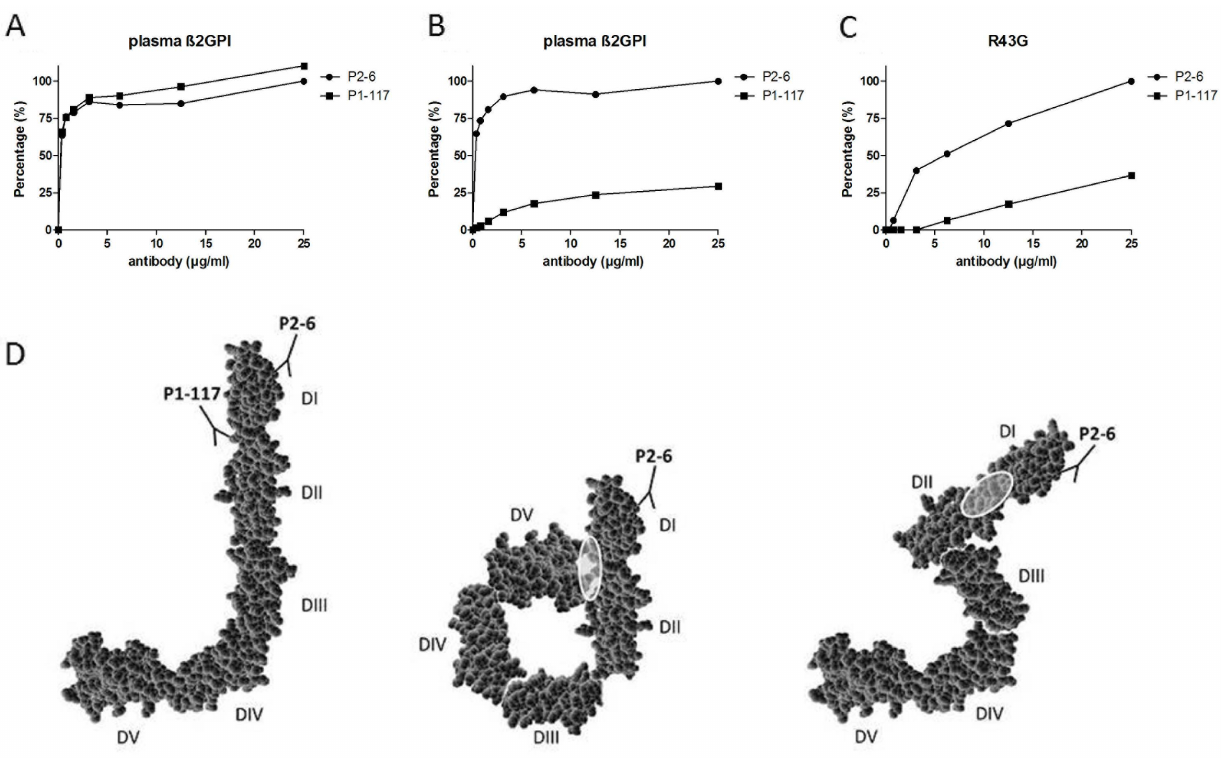
Figure 1. Specificity of monoclonal antibodies P1-117 and P2-6. Two different monoclonal human-derived antibodies to domain I of b 2 GPI, P1-117 and P2-6, were tested for their specificity in an ELISA as described in Material and Methods. Different concentrations (0 to 25 m g/ml) of these antibodies were added to an ELISA plate coated with full-length plasma purified b 2 GPI (A and B) or a full-length b 2 GPI mutant in which arginine 43 was replaced by a glycine (C). These proteins were coated on an anionic plate (A + C) or a neutral plate (B). Results are expressed as the percentage of the maximum OD value. D. b 2 GPI exists in different conformations, an open J-shaped conformation, a circular conformation and a S-shape conformation. The binding sites of P1-117 and P2-6 are indicated. In the circular conformation, interaction of domain I with domain V prevents exposure of the P1-117 epitope. Similarly, in the S-shaped conformation, the carbohydrate residues are positioned in such a way that they shield the P1-117